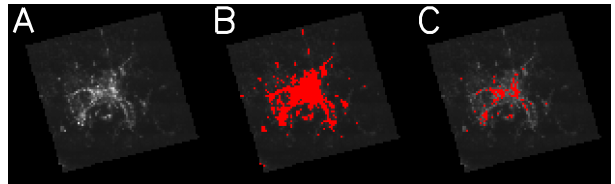
Figure 2. (a) A Raw VIIRS DNB image of Huntsville from the night of 26 June 2013. (b) The same image from (a) with algorith- mically determined city pixels in red. (c) The same as in (b) except that only the 100 brightest city pixels are in